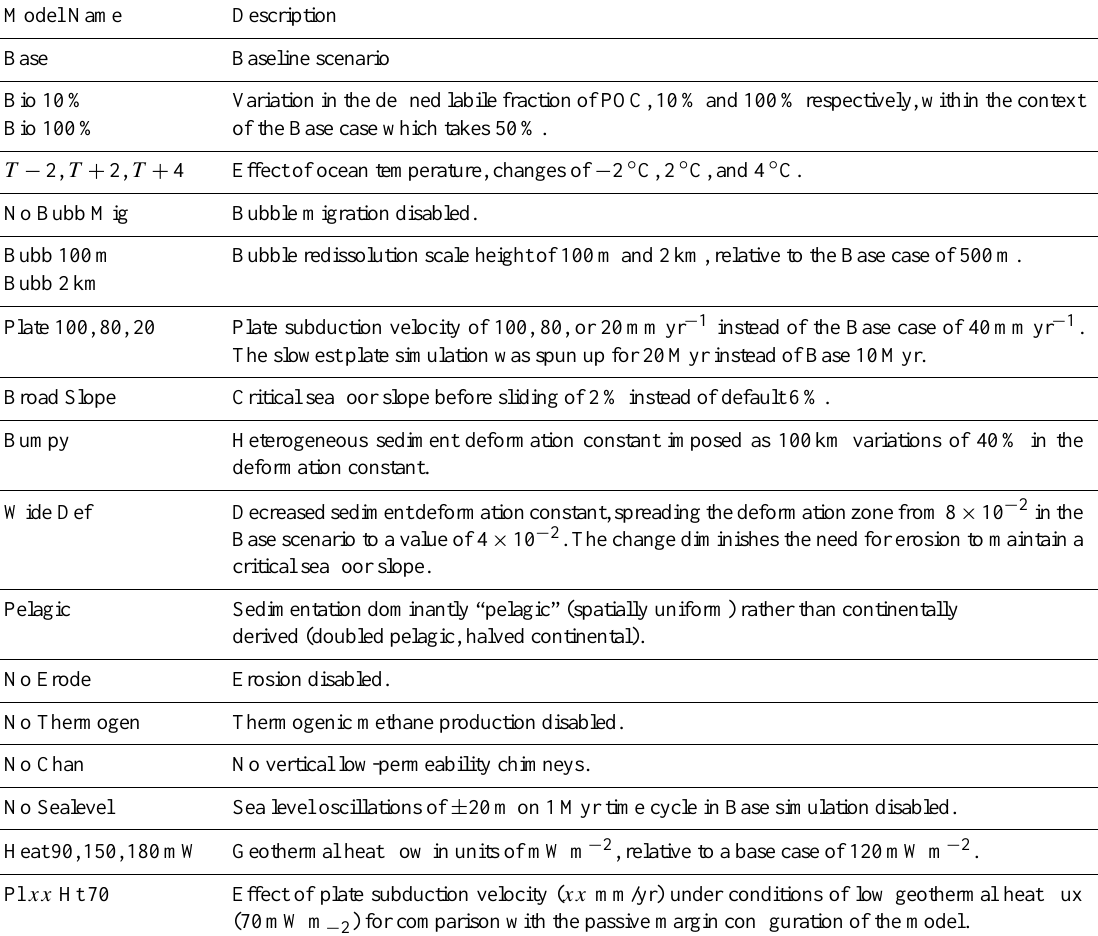
Table 1. Summary of the configurations of model